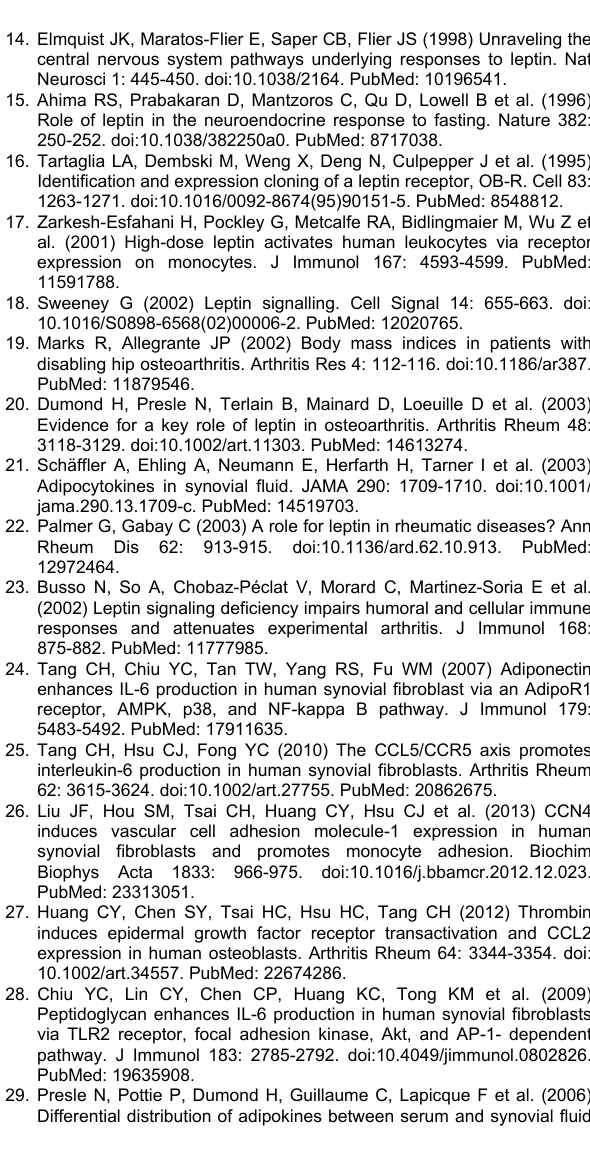
Table S1. Characteristic of OA